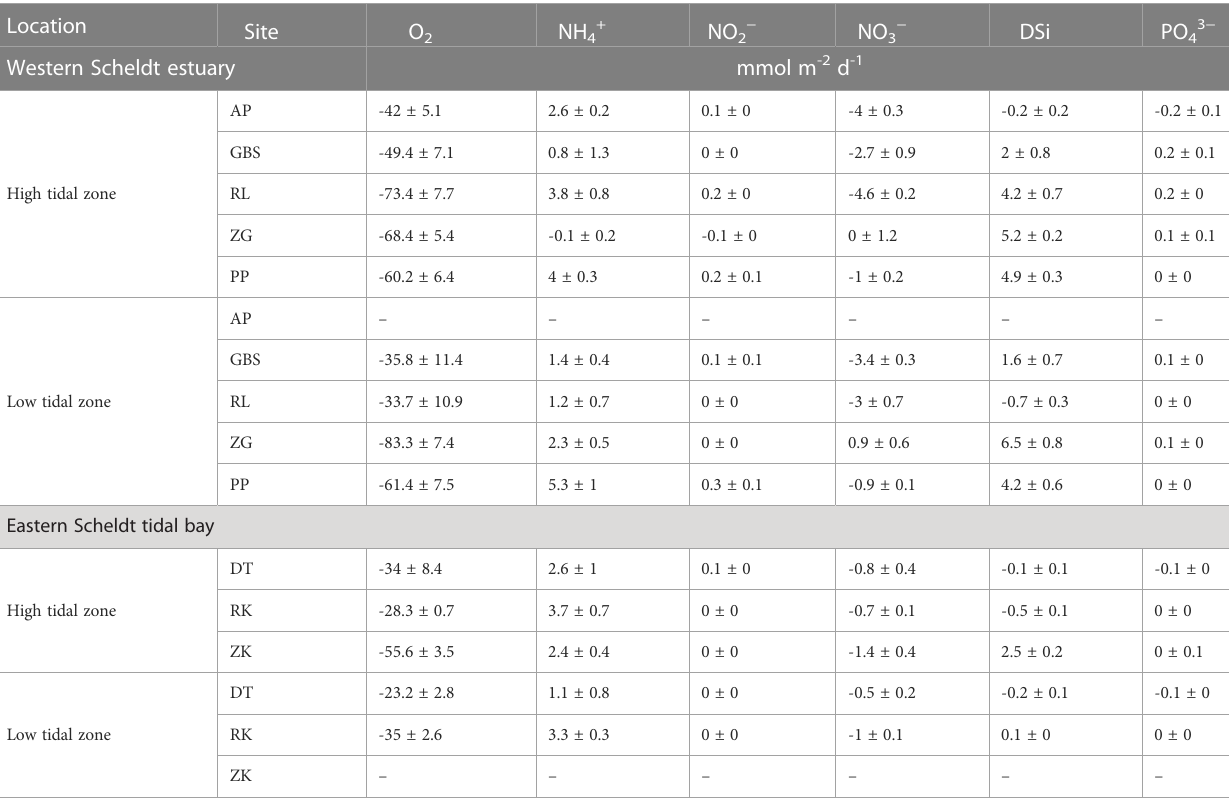
TABLE 2 Mean ± standard deviation of oxygen and nutrient fl uxes (mmol m -2 d -1 ) at the high and low tidal zone locations of the different sites in the Western and Eastern Scheldt.